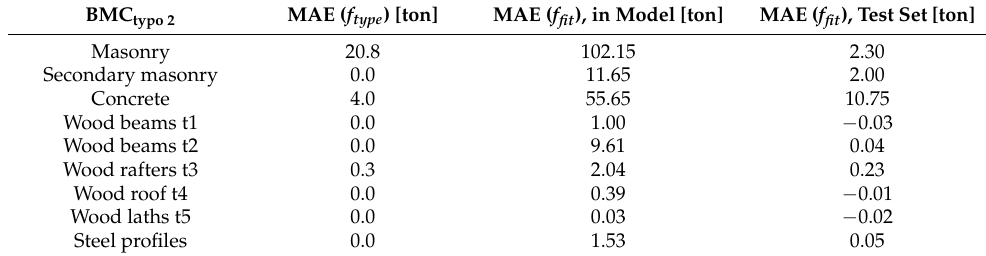
Table 7. Errors due to generative parametric modelling factors.